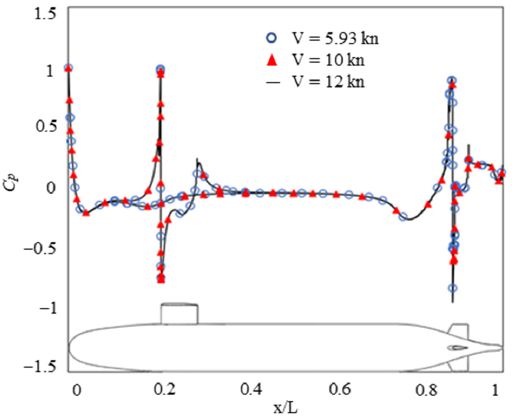
Figure 8. The distribution of the ridge pressure coefficients in the longitudinal profiles.